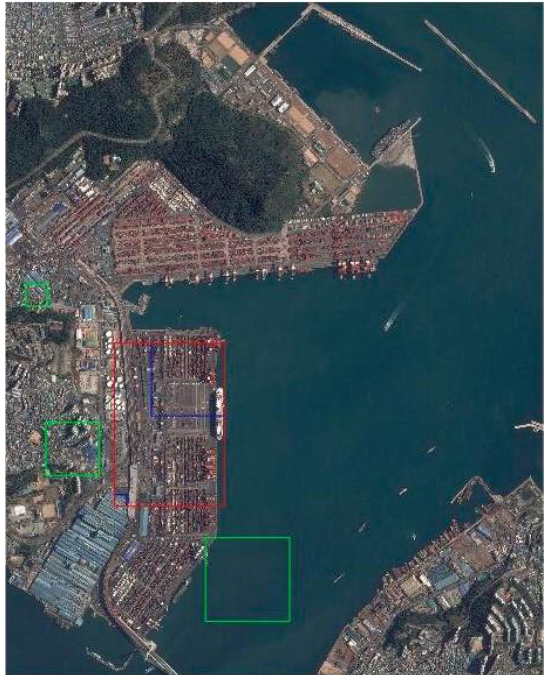
Figure 10. Detection on Busan Port in Republic of Korea by SIFT-based keypoint matching method